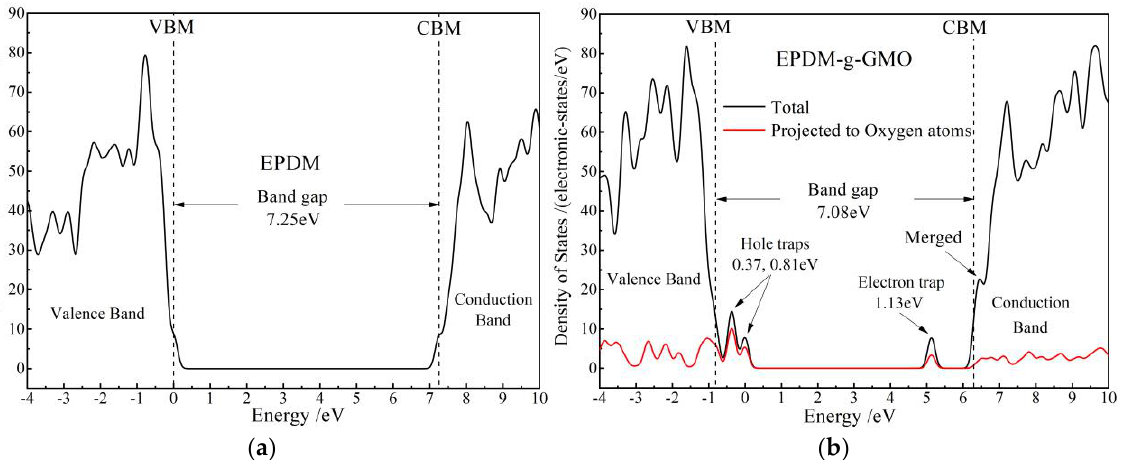
( b ) Figure 9. DC electric-breakdown fields fitted in Weibull statistics of ( a ) EPDM and (b ) EPDM-g- GMO at diverse temperatures from 30 to 70 °C.